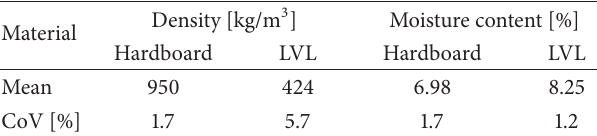
Table 3: The dry density and the moisture content of the hardboard and LVL materials from the PlyBoard panel. (Eight specimens were used for each kind of